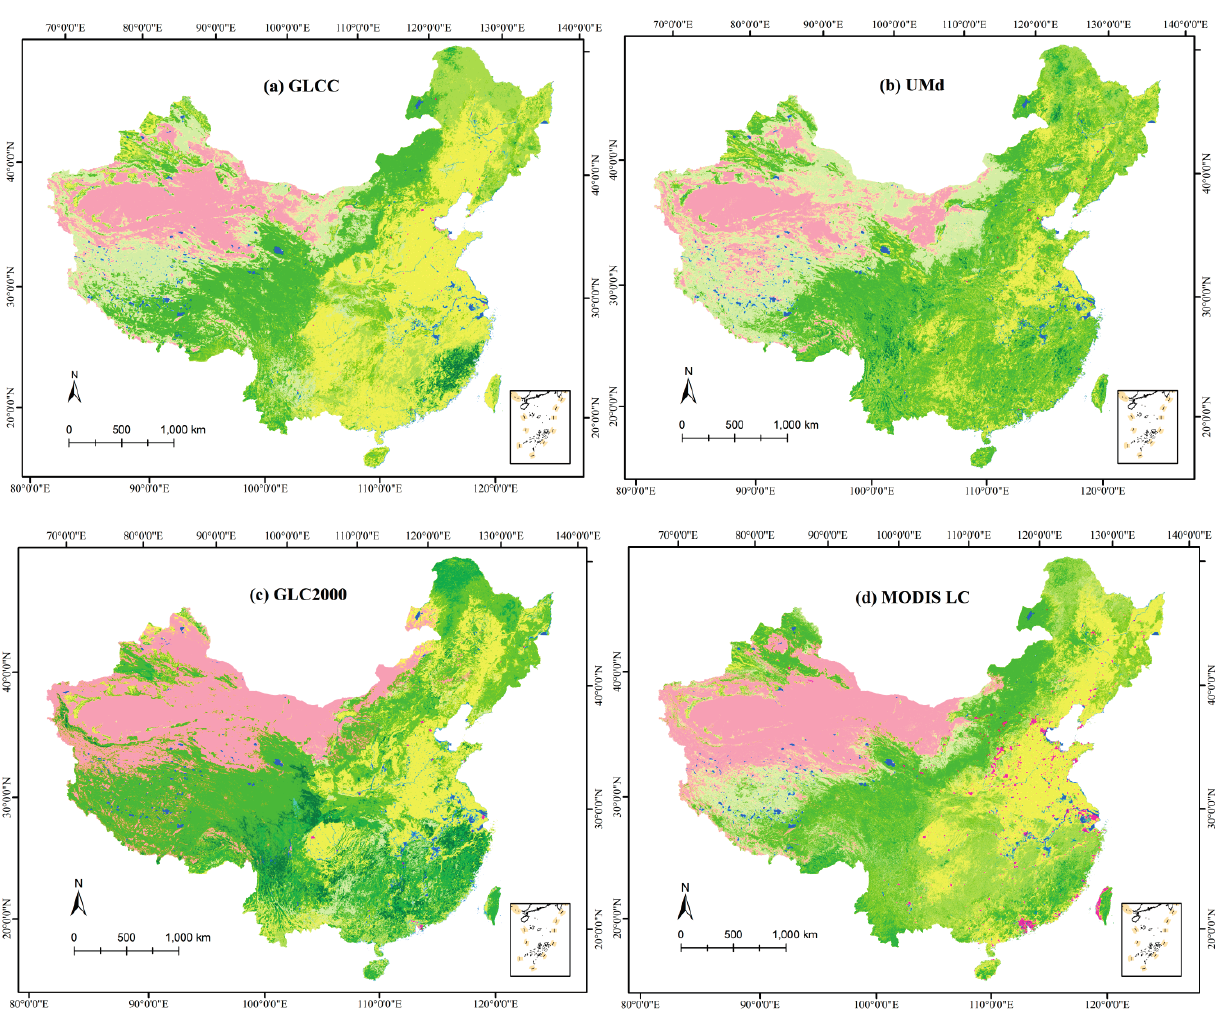
Figure 1. Reclassified ( a ) GLCC, ( b ) UMd, ( c ) GLC2000, ( d ) MODIS LC, ( e ) GlobCover and ( f ) GLCD-2005 in